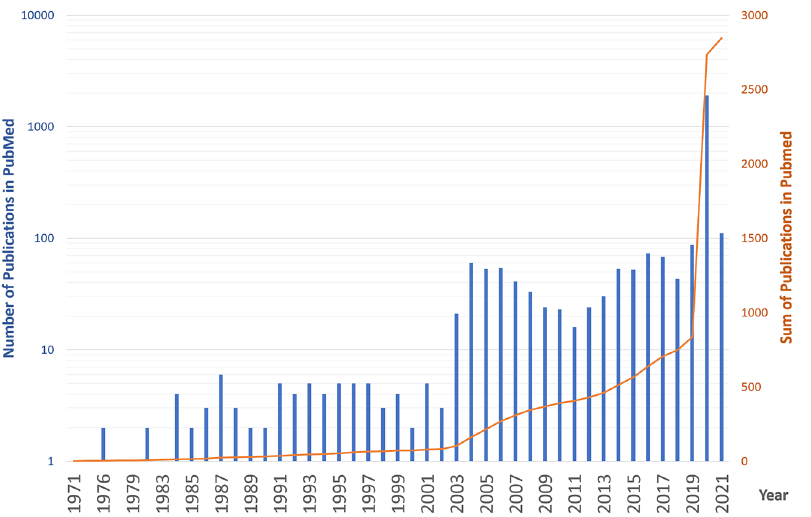
Figure 1: The number of times